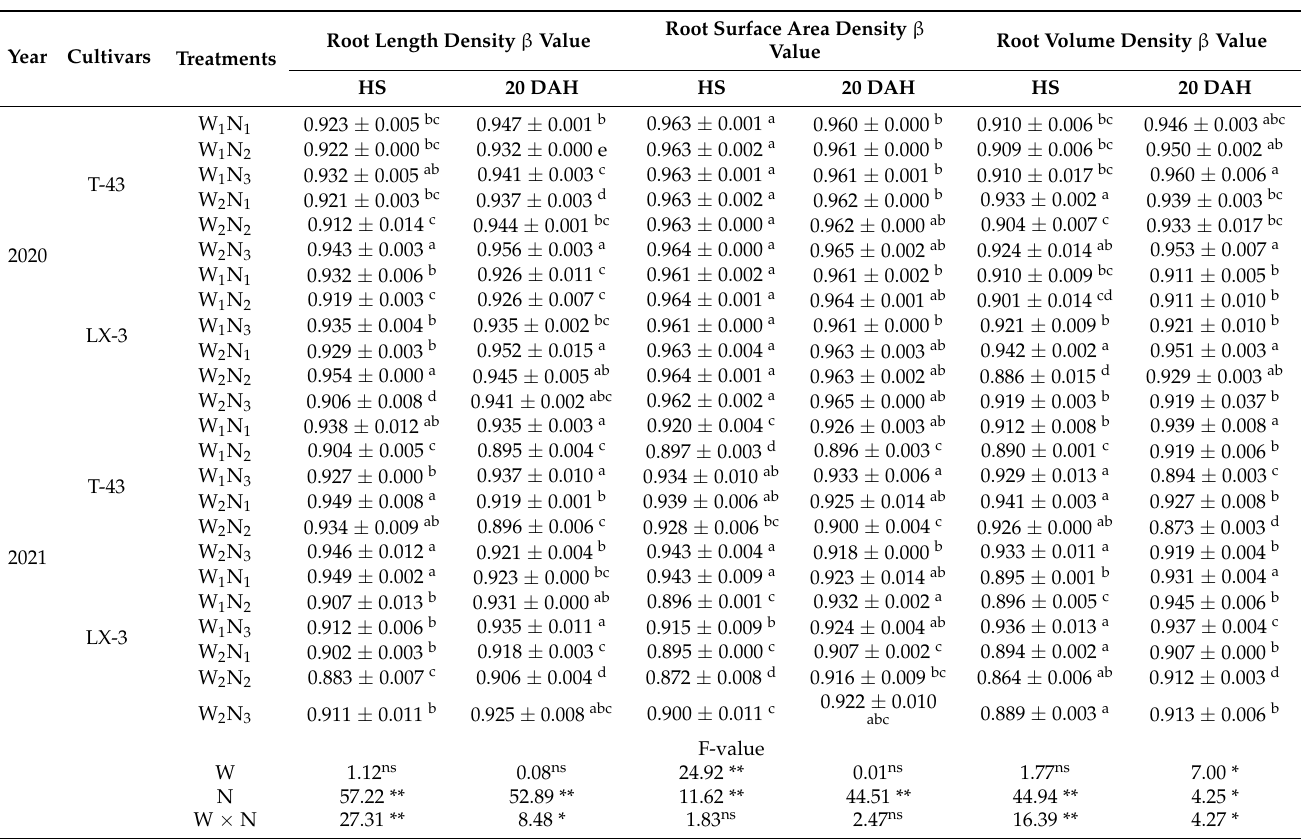
Table 5. Effects of water and nitrogen management on root architecture parameter β of rice under drip